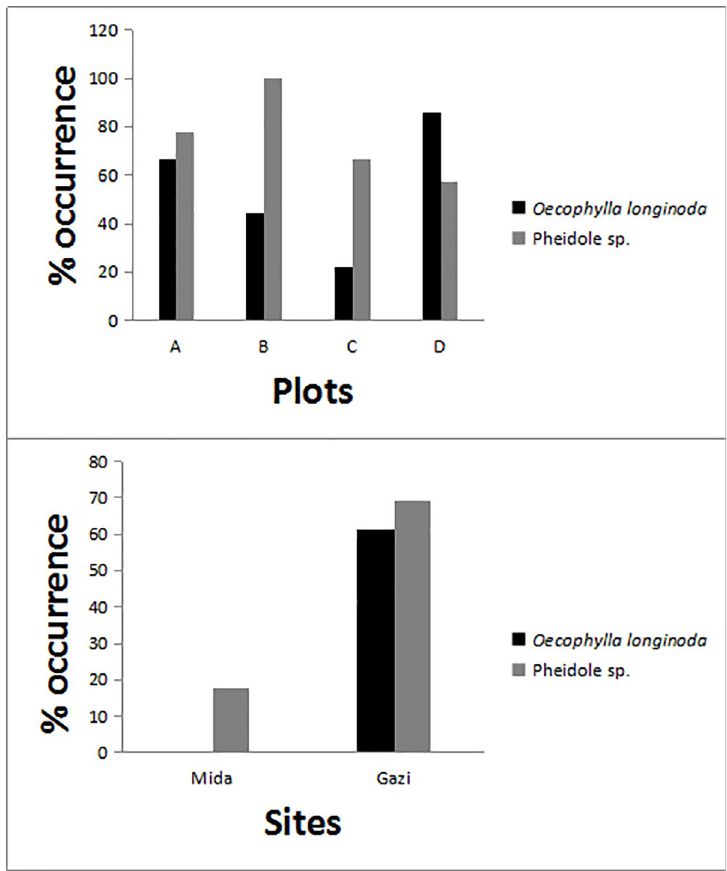
Fig 3. The percentage (%) occurrence of ants ( Oecophylla longinoda and Pheidole sp.) in the four plots in Gazi Bay (top graph) on the sampled trees. The bottom graph shows the average percentage (%) occurrence of the two ant species found inhabiting S . alba trees in the two sampling sites (Mida Creek and Gazi Bay). Oecophylla longinoda was not recorded in Mida